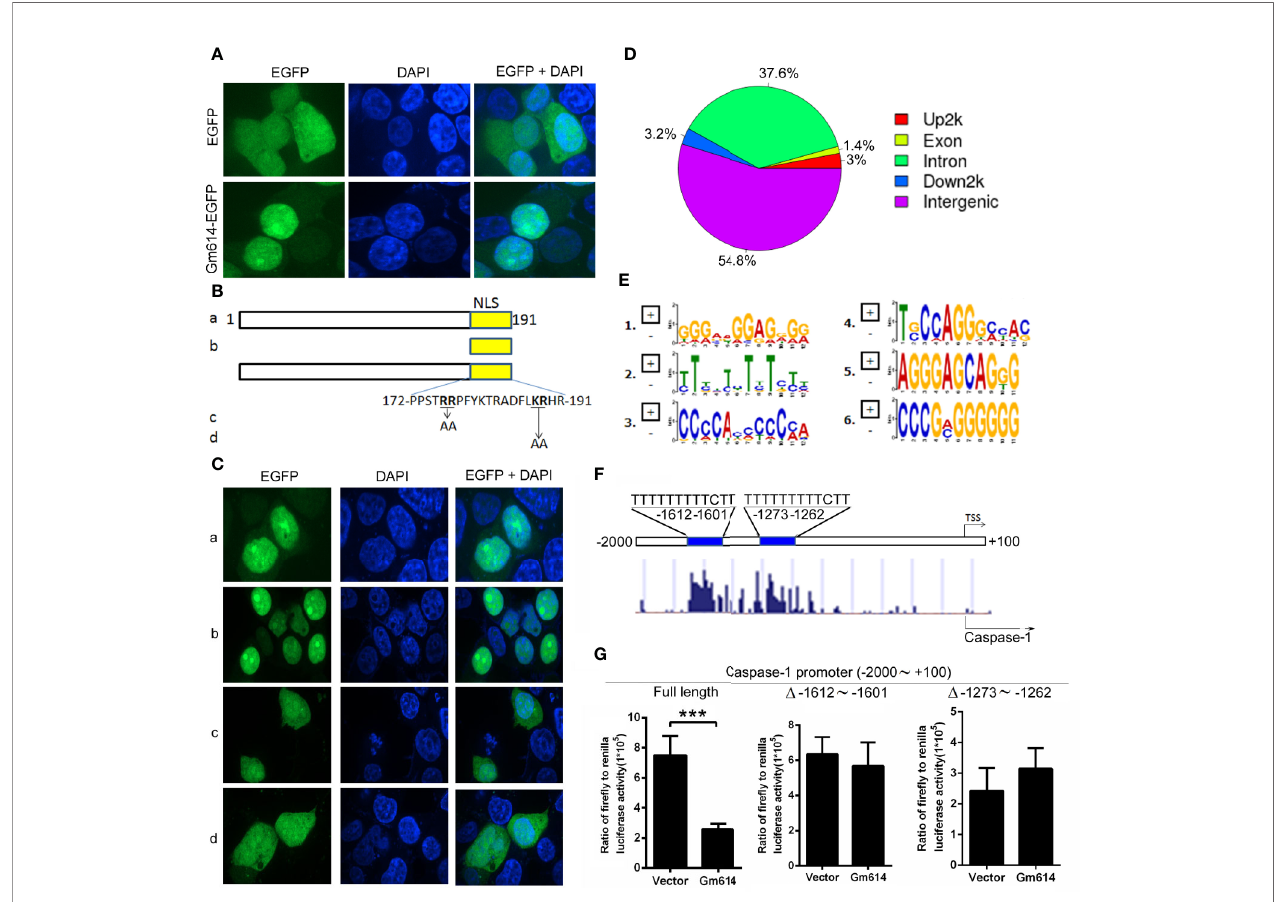
FIGURE 6 | Gm614 suppressed caspase-1 transcription. (A) Gm614 was expressed in the nucleus. CD19 + B220 + CD38 lo GL7 hi GC B cells were infected with lentiviruses with EGFP- or Gm614-EGFP-expressing LV122 and cultured for 2 days. Cells were imaged and analyzed on a GE IN Cell Analyzer 2000. Representative images show the nuclear location of Gm614. (B, C) Nuclear localization sequence (NLS) was located in C-terminal (172 ∼ 191) of Gm614. LV122 lentiviruses expressing (A) full length (1 – 191)-EGFP, (b) NLS (172 – 191)-EGFP, (c) full length with AA (176 – 177) mutation-EGFP, or (d) full length with AA (188 – 189) mutation- EGFP (B) were infected into CD19 + B220 + CD38 lo GL7 hi GC B cells and on day 2, cells were imaged on a GE IN Cell Analyzer 2000 (C) . (D – F) Gm614 bound with the caspase-1 promoter. CD19 + B220 + CD38 lo GL7 hi GC B cells were infected with lentiviruses containing EGFP- or Gm614-EGFP-expressing LV122, and cultured for 3 days. Genome-wide mapping of Gm614 binding in GC B cells by ChIP-seq. (D) Distribution of Gm614-binding peaks. (E) De novo motif prediction by DNA sequences enriched in Gm614 binding regions. (F) Genomic snapshots depicting the ChIP-seq results for Gm614 (lower panel) and the predicted motif (upper panel) at the promoter regions of the caspase-1 genomic loci. (G) Gm614 suppressed the activation of caspase-1 promoter. Gm614-expressing LV201 (Gm614) or empty vector LV 201 (Vector) and luciferase reporter vector pEZX-PG04.1/caspase-1 promoter (-2000 ∼ +100 bp of mouse caspase-1 gene) (Full length), caspase-1 promoter with the deletion of -1612 ∼ -1601 ( D -1612 ∼ -1601) or -1273 ∼ -1262 ( D -1273 ∼ -1262) were co-transduced into 293T cells. Dual luciferase reporter gene expression was analyzed, and the results are shown as the ratio of fi re fl y to Renilla luciferase activity. (A, C, G) Data represent three independent